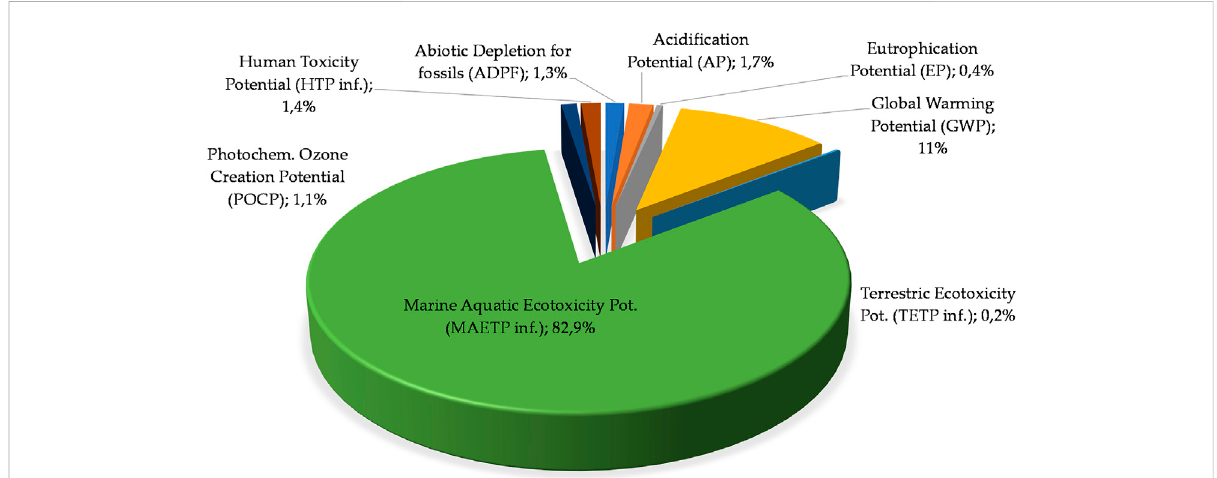
FIGURE 2 Percentage distribution of impact categories for incineration in percent (functional unit: MSW of 1 kg). Normalisation reference: CML 2016, EU 25 + 3, year 2000, excl. biogenic carbon. Weighting method: thinkstep LCIA Survey 2012, Europe, CML 2016, excl. biogenic carbon). In Scenario 1, 0.476 MJ of waste heat, 0.016 MJ of unusedprimary energy, 0.081 kg of used air, 0.248 kg of processed water to groundwater, 0.005 kg of cooling watertoariver,0.728 kgofcollectedrainwater,0.011 kgofturbidwatertoariver,0.216 kgofcarbondioxidetotheair,and0.297 MJofelectric power (electricity from land fi ll gas utilization) were generated from 1 kg of MSW. In Scenario 2, 1.23 MJ of electric power was generated, and energy feedback can be reused in a speci fi cally designed plant. (Source: own analyzes with GaBi 8.0 software).